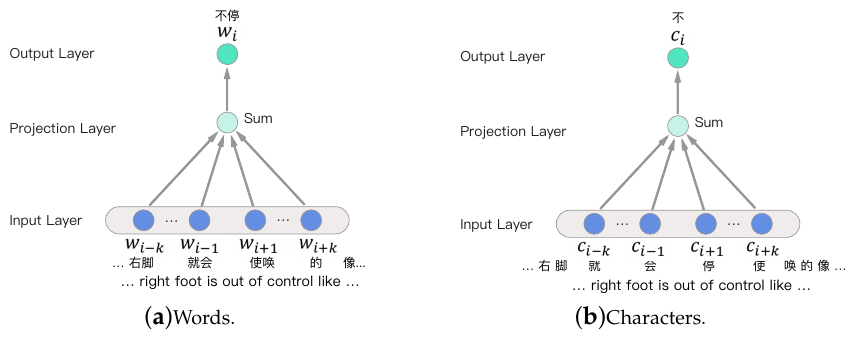
Figure 2. Distributed representation of words and